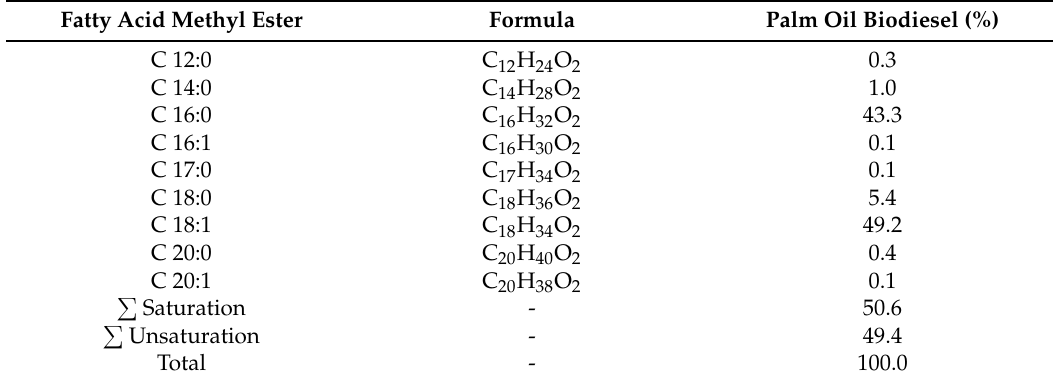
Table 1. Palm oil biodiesel fatty acid composition.